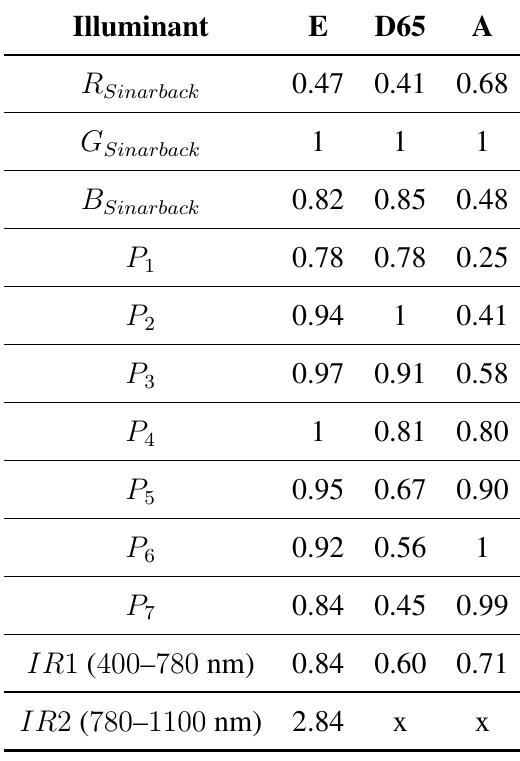
) by the filter, for a given input p